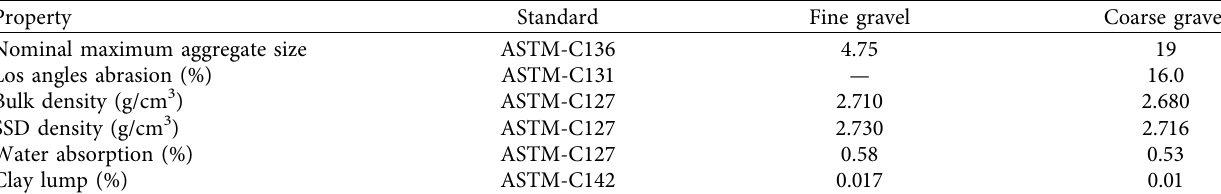
Table 1: Physical properties of aggregate.